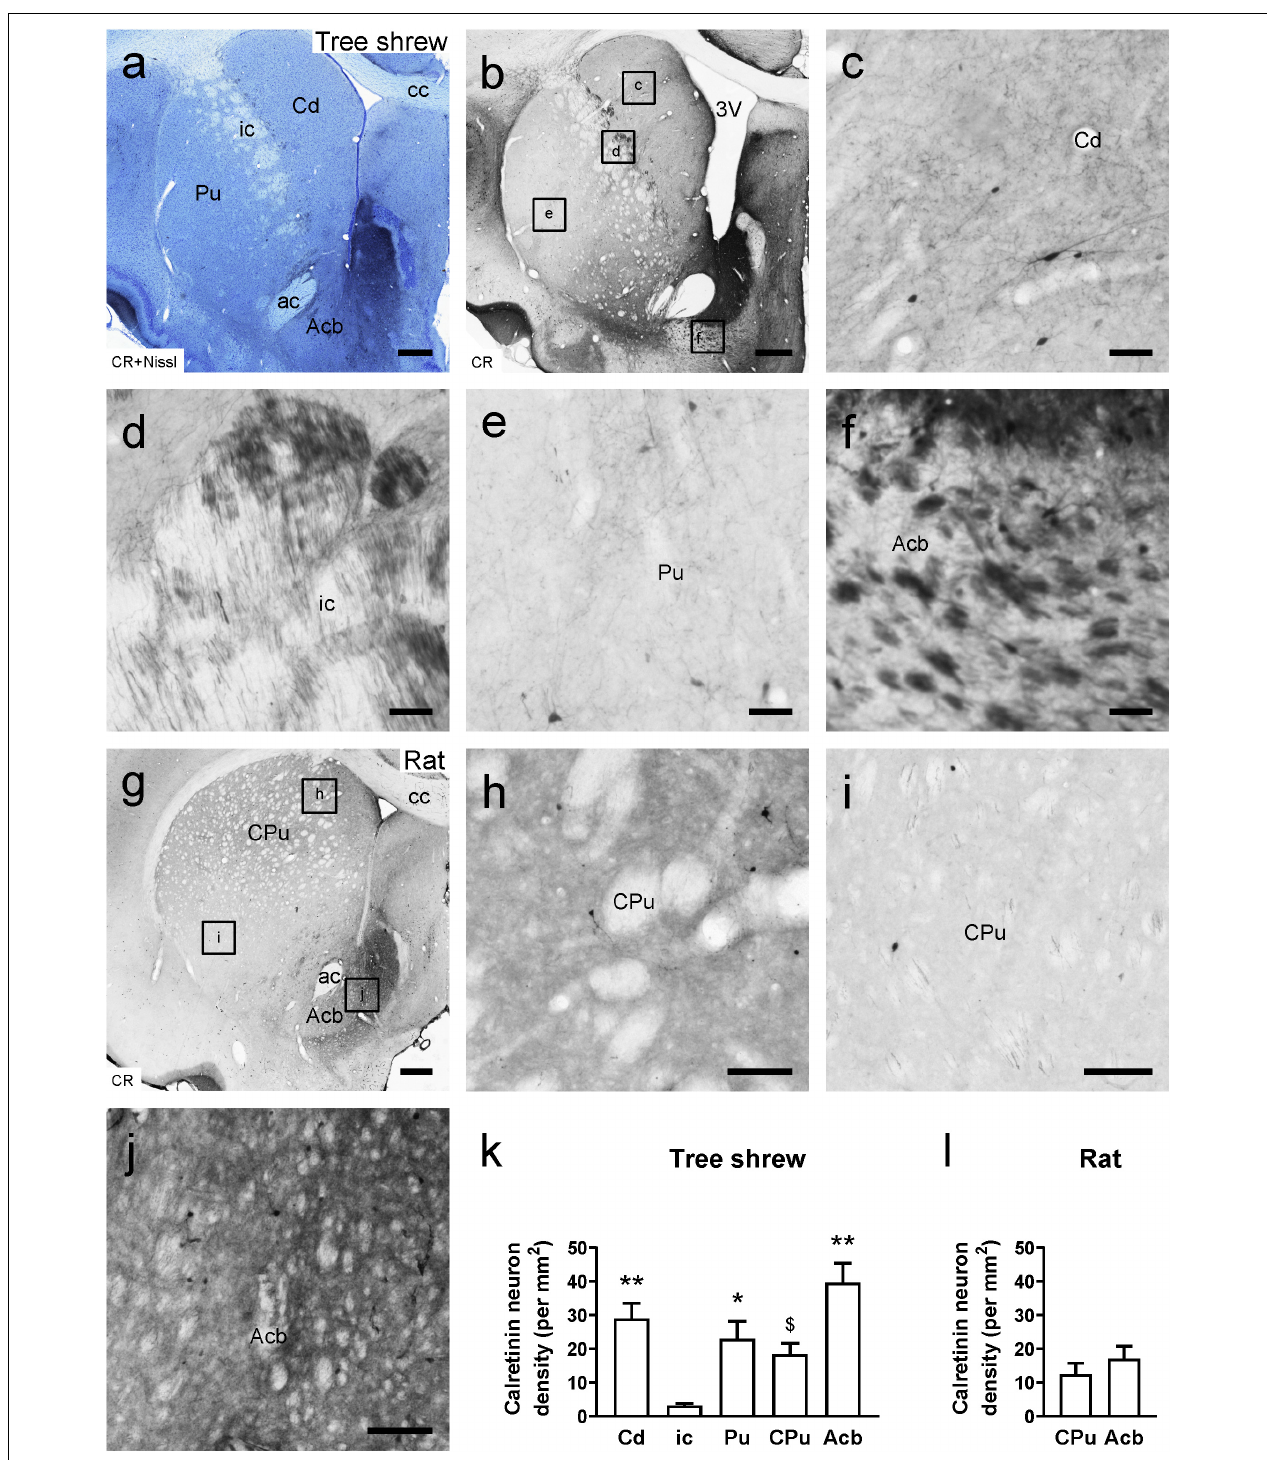
FIGURE 3 | Bright-field photomicrographs of calretinin (CR) immunoreactivity are shown in the tree shrew and rat striata. (a) Low-magnification photomicrograph showing Nissl staining (blue) following CR-ir staining (black) in the tree shrew striatum. (b) Low-magnification photomicrograph illustrating CR immunoreactivity in an adjacent section of the striatum. (c–f) High-magnification image of CR-ir neurons and fibers in the caudate nucleus (Cd), internal capsule (ic), putamen (Pu), and accumbens nucleus (Acb) of the striatum (boxed area in b ). (g) Low-magnification photomicrograph illustrating CR immunoreactivity in an equivalent section of the rat striatum. (h–j) High-magnification image of CR immunoreactivity in the caudate putamen (CPu) and Acb of the rat striatum (boxed area in g ). (k) Comparison of